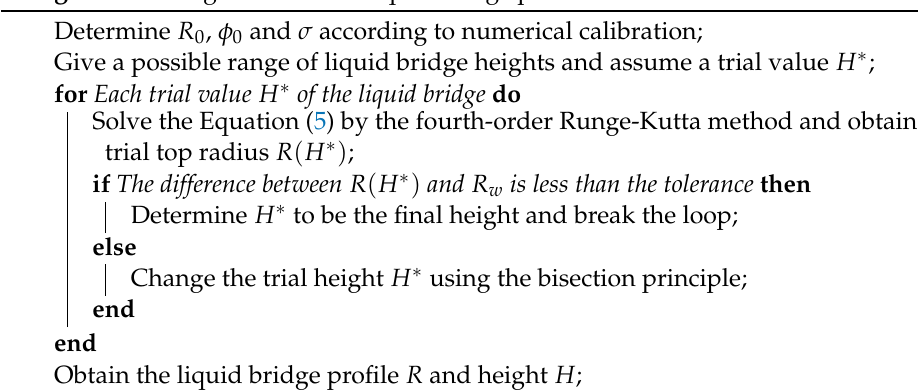
Algorithm 1: Algorithm to the liquid bridge